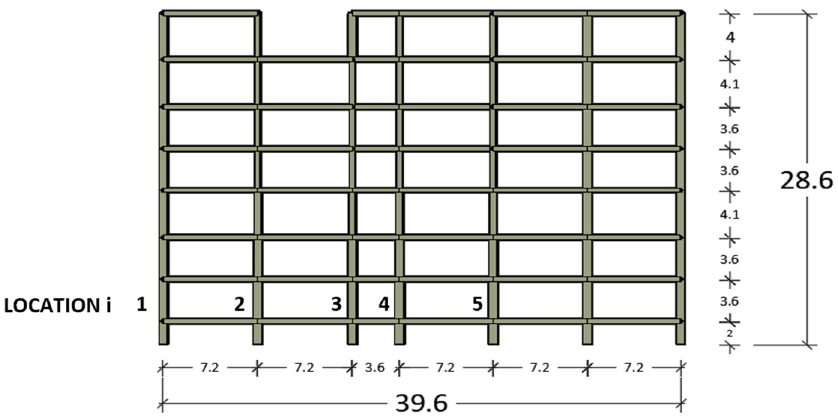
Figure 9. 2D RC frame structure and different locations assumed for the blast damage (sizes in m).